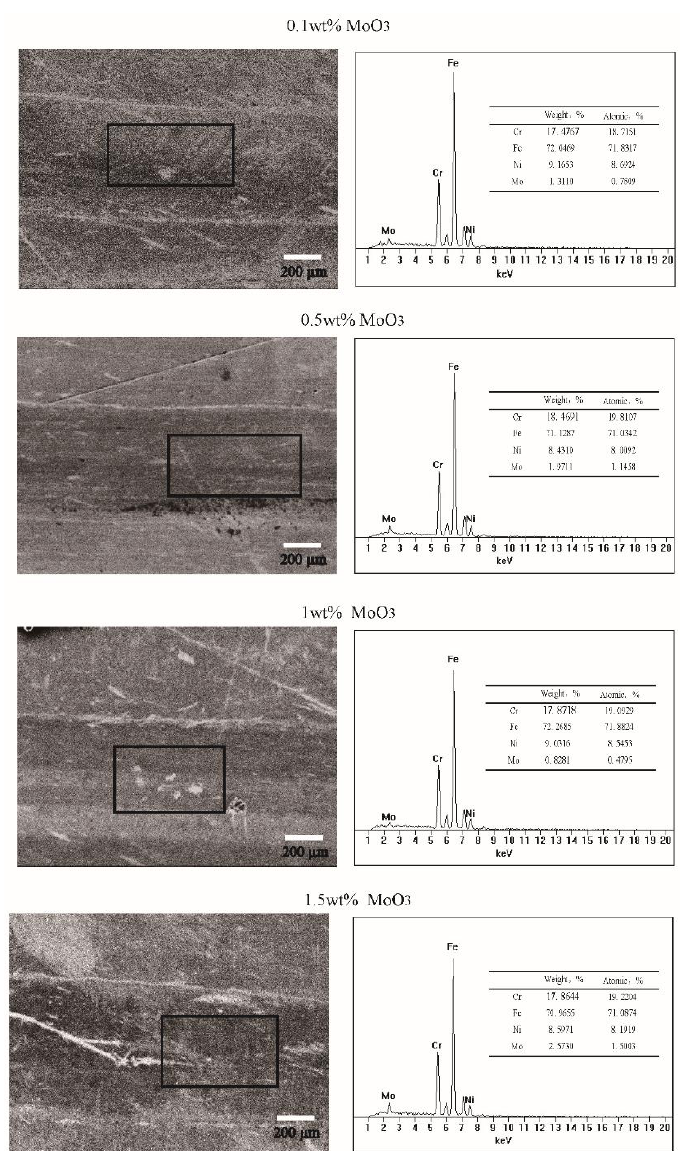
Figure 6. Energy dispersive X-ray spectroscopy (EDS) data of the wear scars lubricated by base oil with different concentrations of micro-lamellar MoO 3 additives. Materials 2018 , 11 , x FOR PEER REVIEW